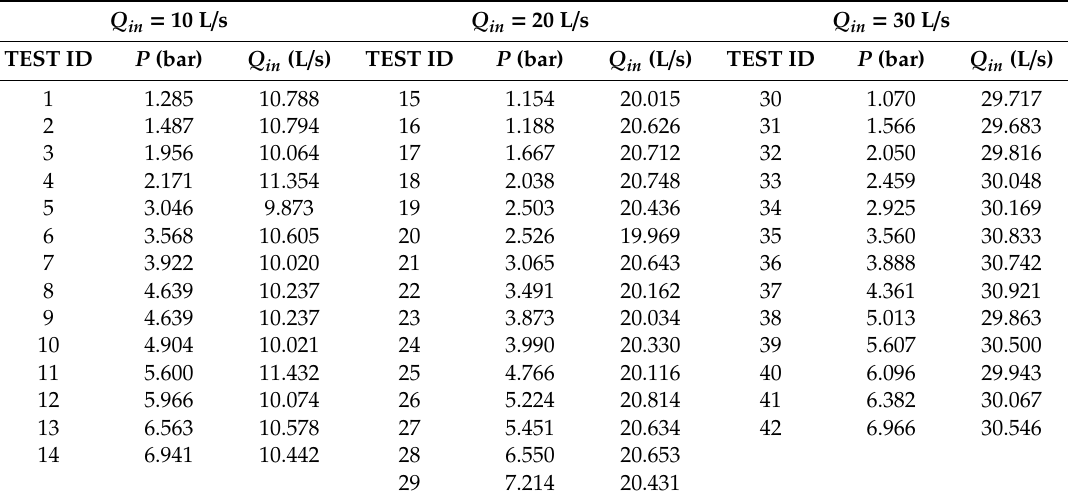
Table 2. Set of performed experimental tests.